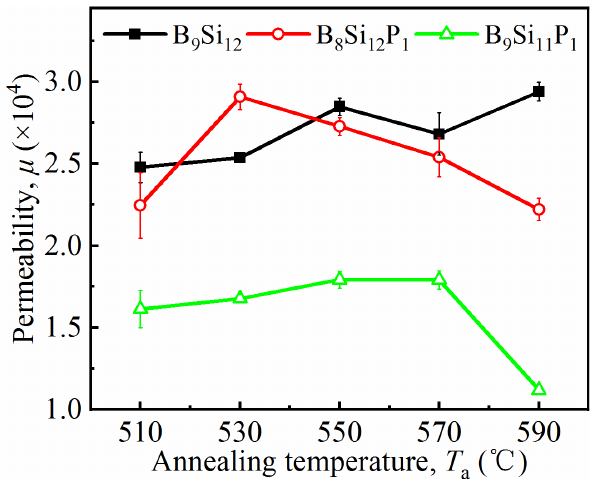
Figure 4. μ of B 9 Si 12 , B 8 Si 12 P 1 and B 9 Si 11 P 1 ribbons at 1 kHz as a function of annealing temperature. The annealing time is 60 min.